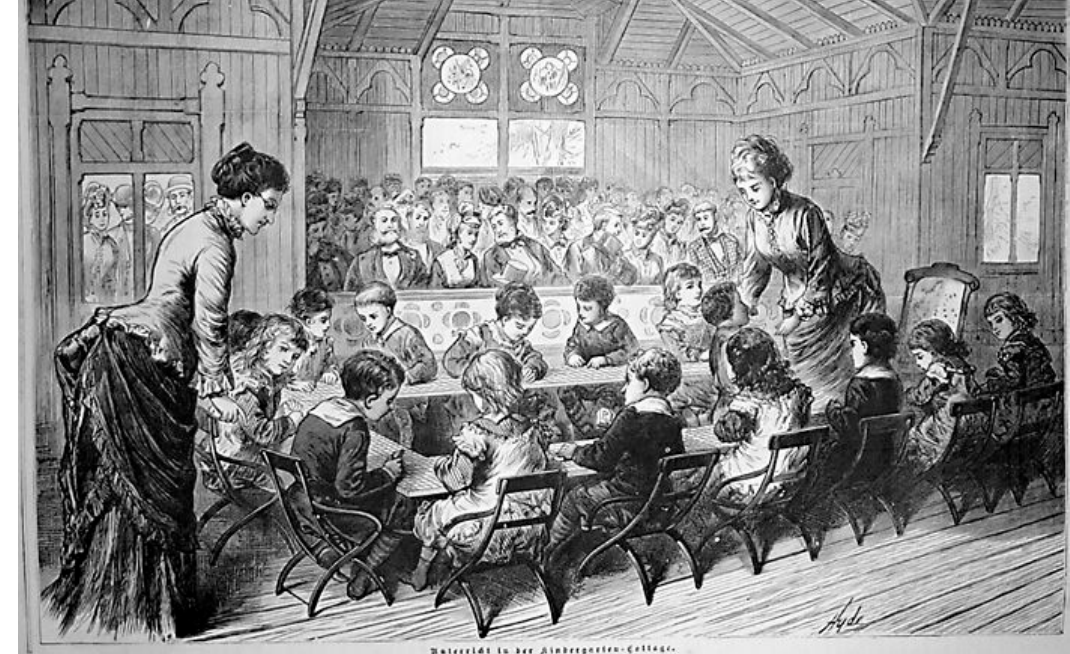
Figure 1. The Illustrated History of the Centennial Exhibition , by James D. McCabe, published in Philadelphia,